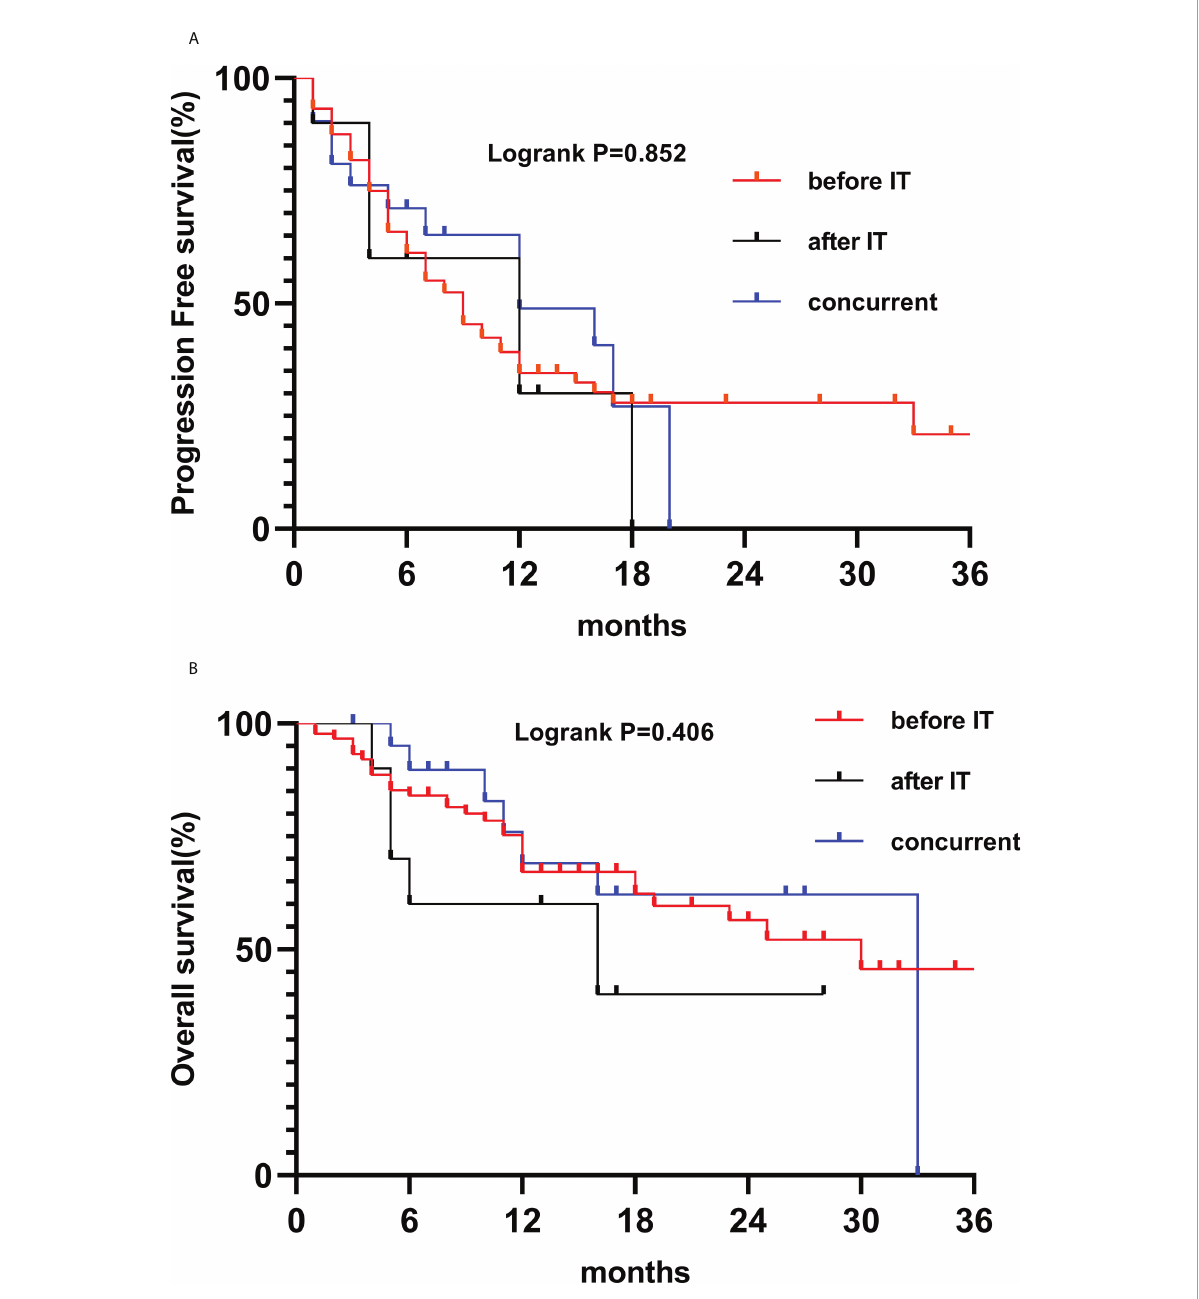
FIGURE 4 Kaplan-Meier survival curves of PFS (A) and OS (B) according to RT before IT (n=88), after IT (n=10) and concurrent